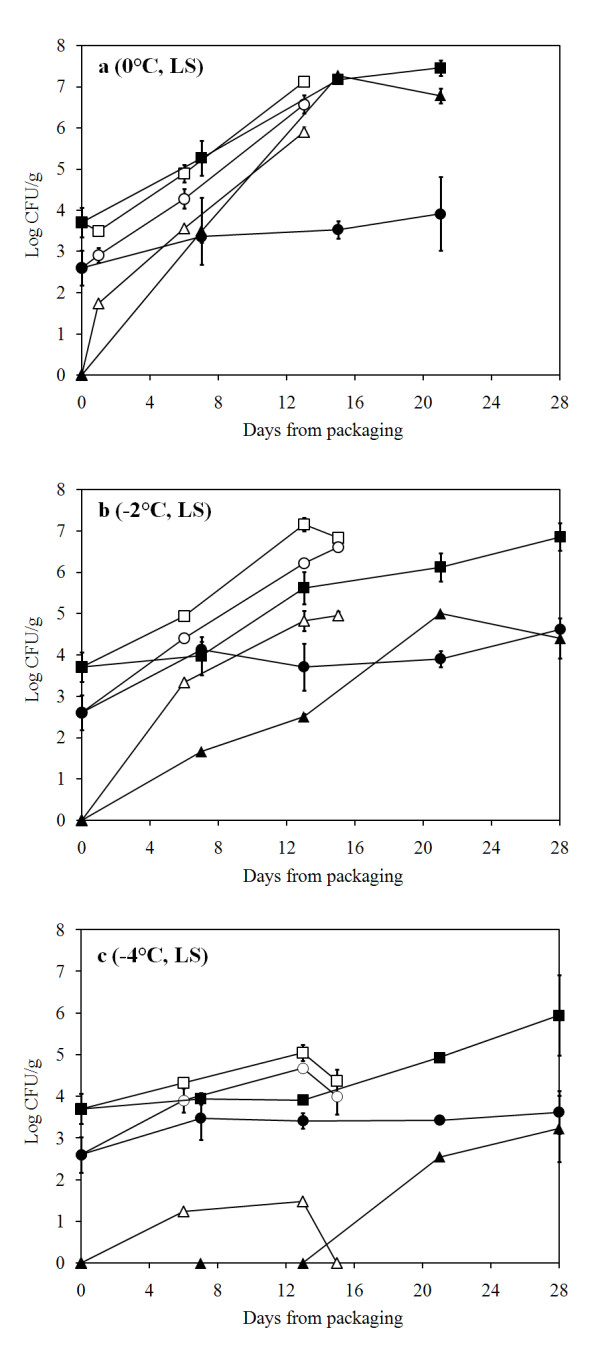
Bacterial growth in air and MA cod loins (LS). Bacterial growth in air- and MA-packaged cod loins (LS) during storage at A) 0°C, B) -2°C and C) -4°C. (black square) Total psychrotrophic viable counts in MA, (white square) total psychrotrophic viable counts in air, (black circle) presumptive Pseudomonas counts in MA, (white circle) presumptive Pseudomonas counts in air, (black triangle) P. phosphoreum in MA and (white triangle) P. phosphoreum in air.